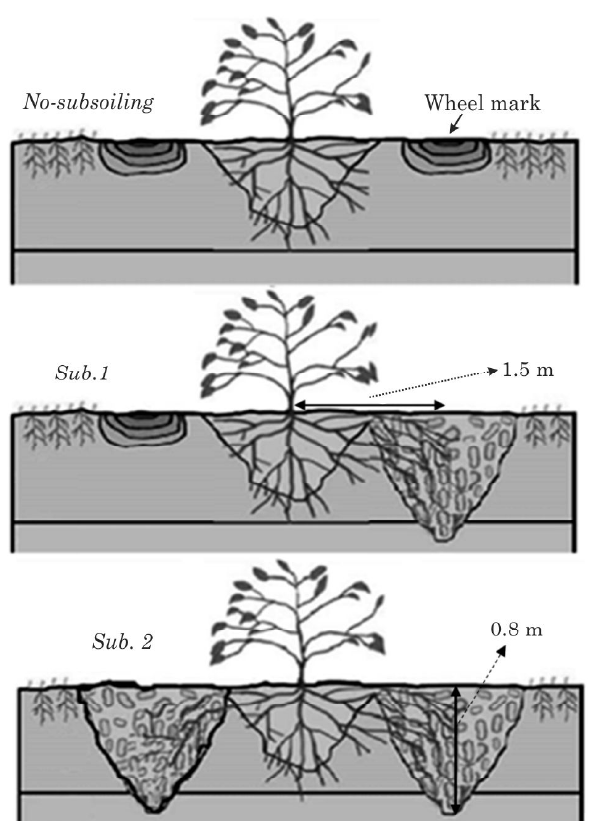
Figure 1. Diagram representing the treatments: No- subsoiling: without soil tillage; Sub. 1 : subsoiling on one side of the citrus plant lines, and Sub. 2 : subsoiling on both sides of the citrus plant lines. Extracted from Mafes Agromecânica